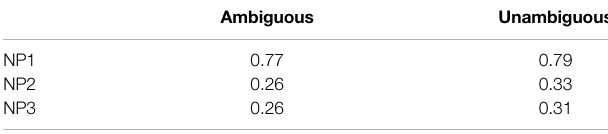
TABLE 3 | Proportion of pronominalization by ambiguous vs unambiguous referents in Experiment 1 in the full stop prompt condition.